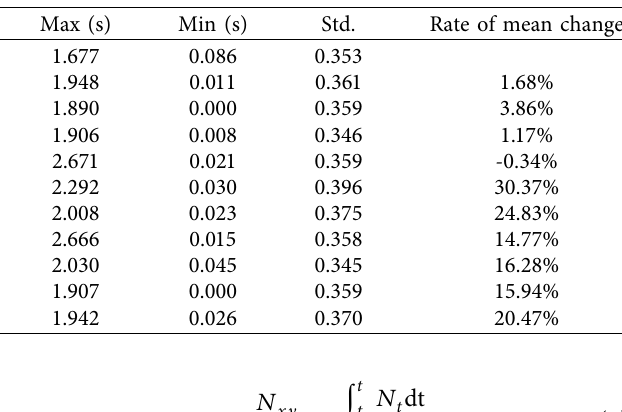
Table 3: Descriptive statistics of speed under different